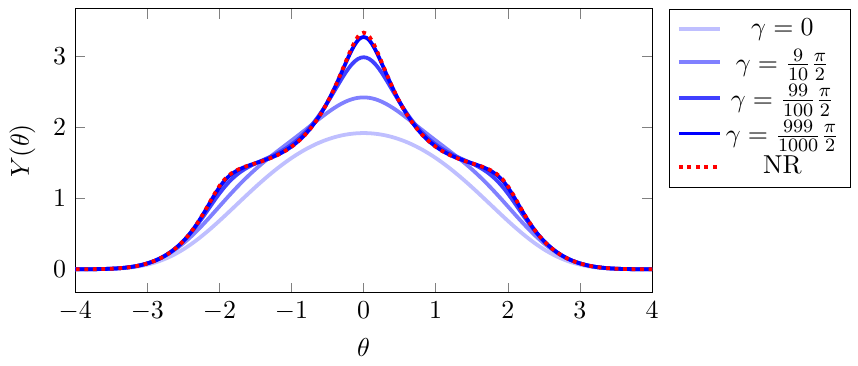
Figure 10. Approaching the Narrow Resonance (NR) limit for θ 0 = 2 and x = 1 . 75